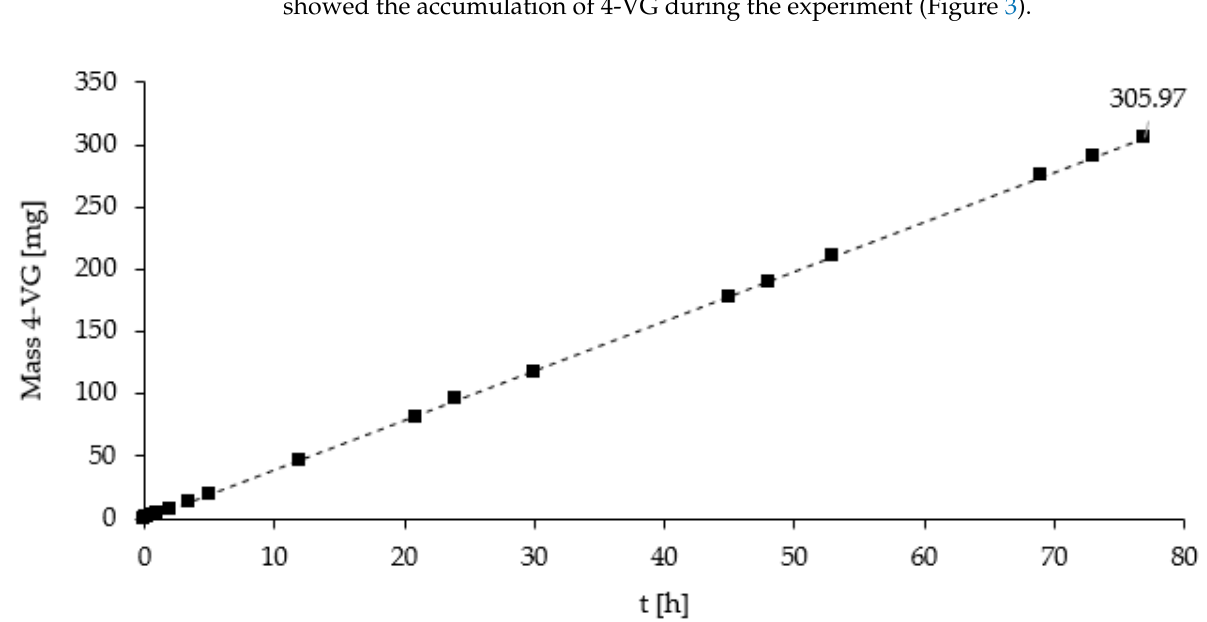
Figure 3. Process productivity graph. From the area under the curve of the 4-VG concentration from Figure 2a, the accumulated product mass after the respective reaction time was calculated.